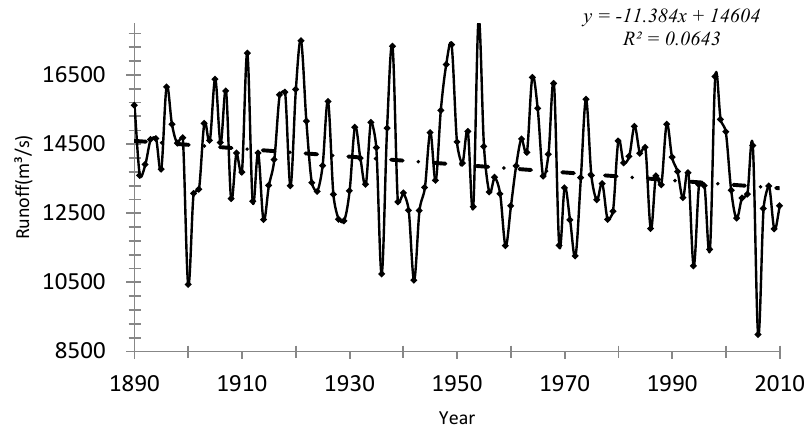
Fig. 3 Annual runoff time series of Yichang station.